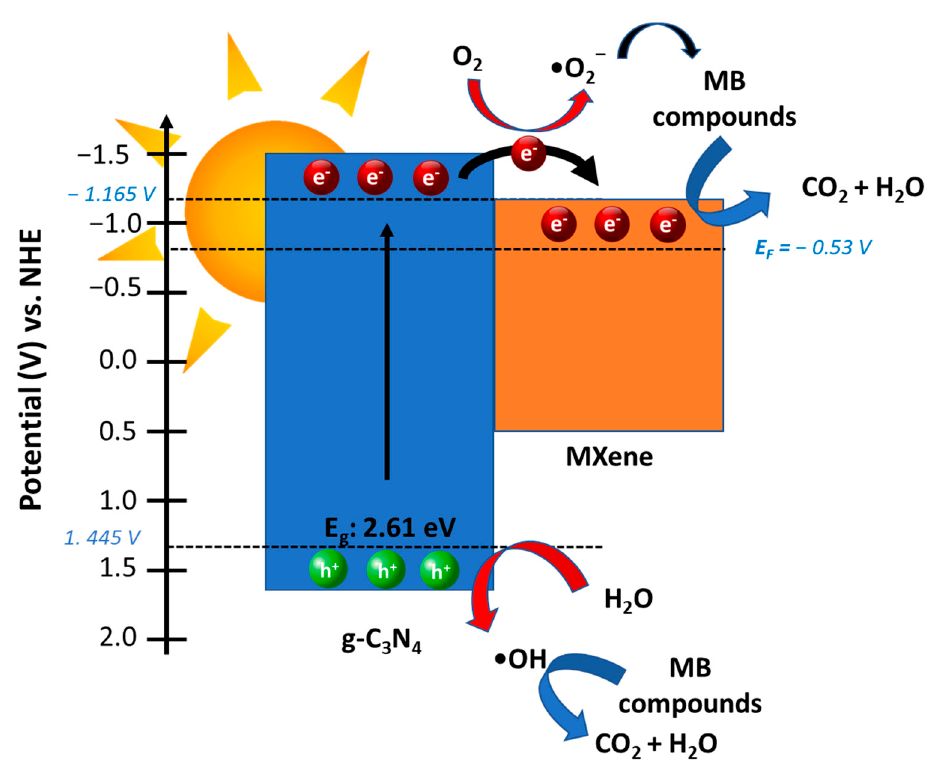
Figure 11. The possible degradation mechanism for photocatalyst reaction of MXene/g-C 3 N 4 heterostructure photocatalyst.